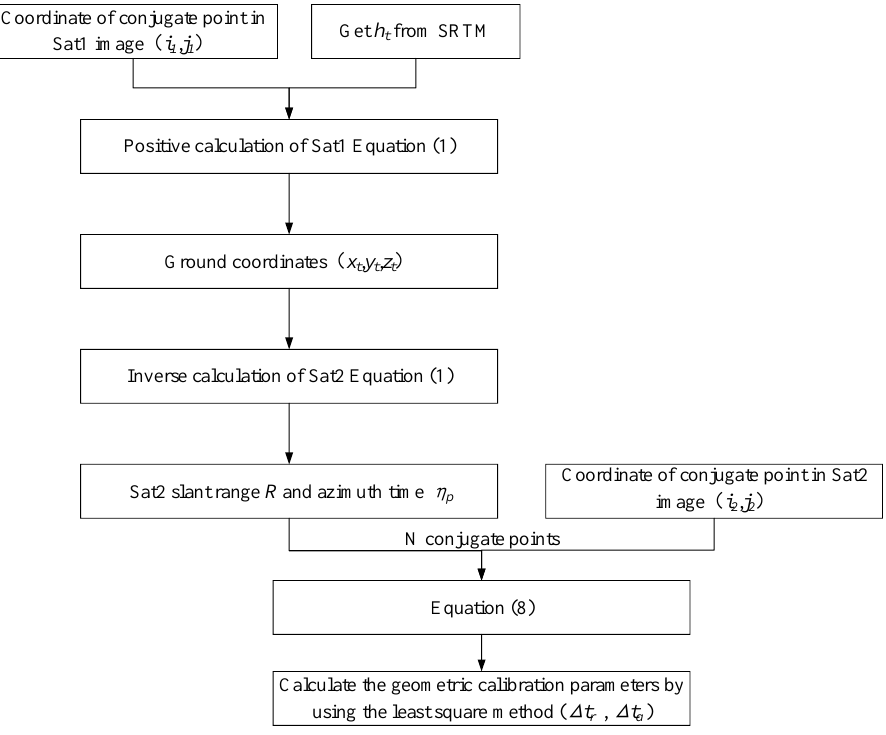
Figure 4. Flow chart of cross-calibration algorithm; h t ; height of the target relative to the surface of the Earth; SRTM: Shuttle Radar Topography Mission.